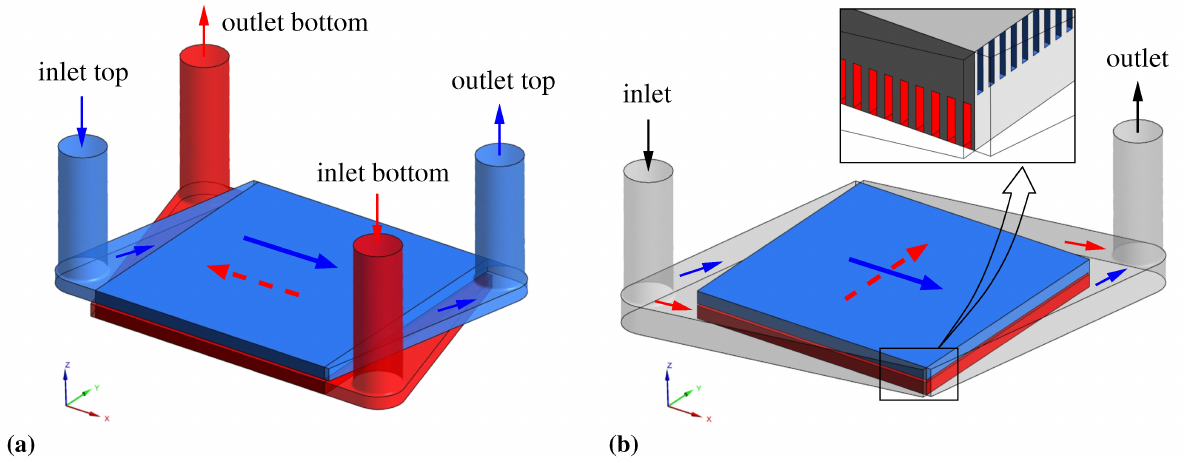
Figure 1. Overall geometry of MCHSs, including headers and inlet/outlet ports: ( a ) counter-flow configuration; ( b ) cross-flow configuration. Box: enlargement of a detail of the microchannels in top and bottom